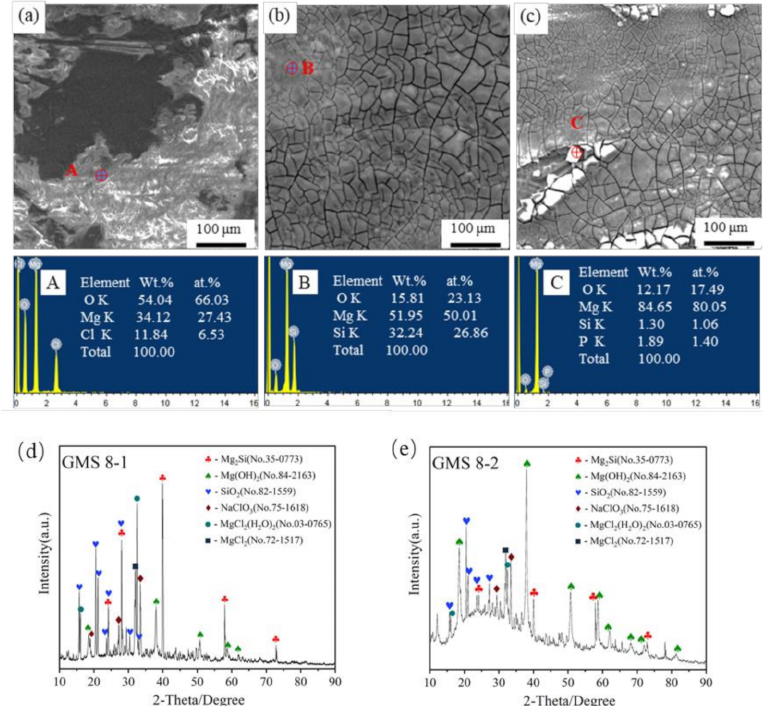
Figure 4. Surface morphologies of specimens after 7 days immersion: MS8 ( a ), GMS8-1 ( b ), GMS8-2 ( c ) by SEM with the EDS results of Point A, B and C; X-ray diffraction patterns of corrosion products on GMS8-1 ( d ), GMS8-2 ( e